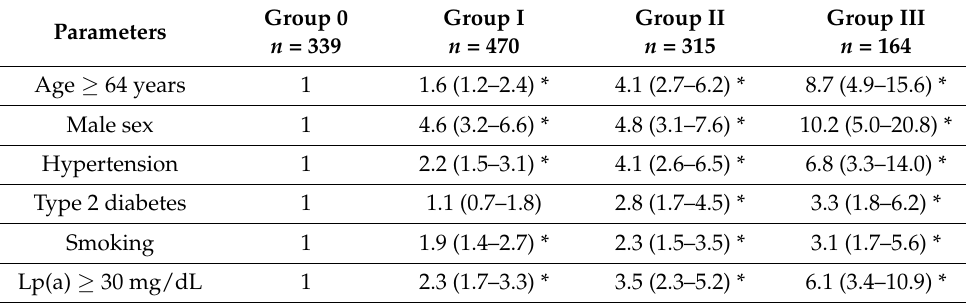
Figure 2. The distribution of elevated level of lipoprotein(a) ( A ) depending on the number of affected vascular beds, ( B ) in patients with different cardiovascular diseases. CAD: coronary artery disease, CVD: cerebrovascular disease, LEAD: lower extremity artery disease. Table 2. The odds ratios of stenotic atherosclerosis, depending on risk